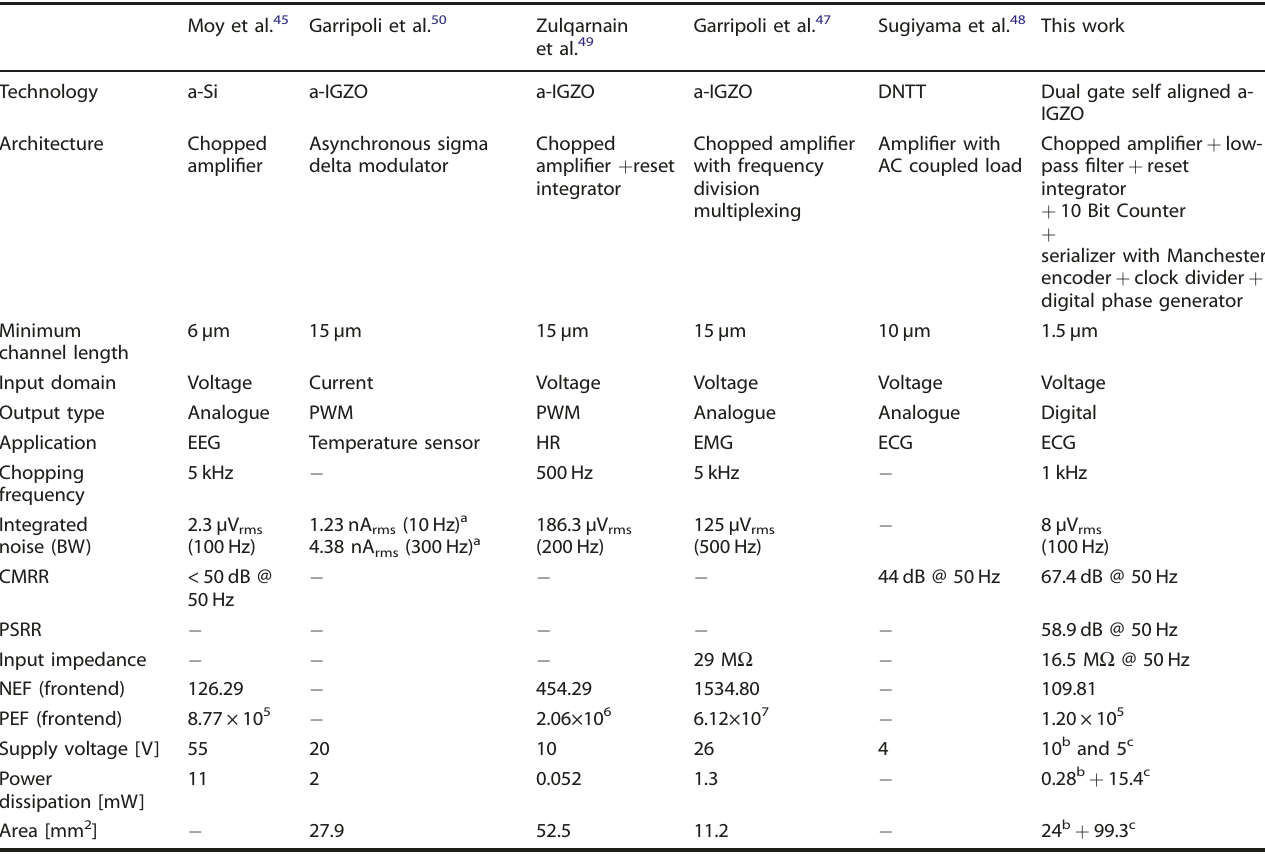
Table 1. Comparison with the state of the